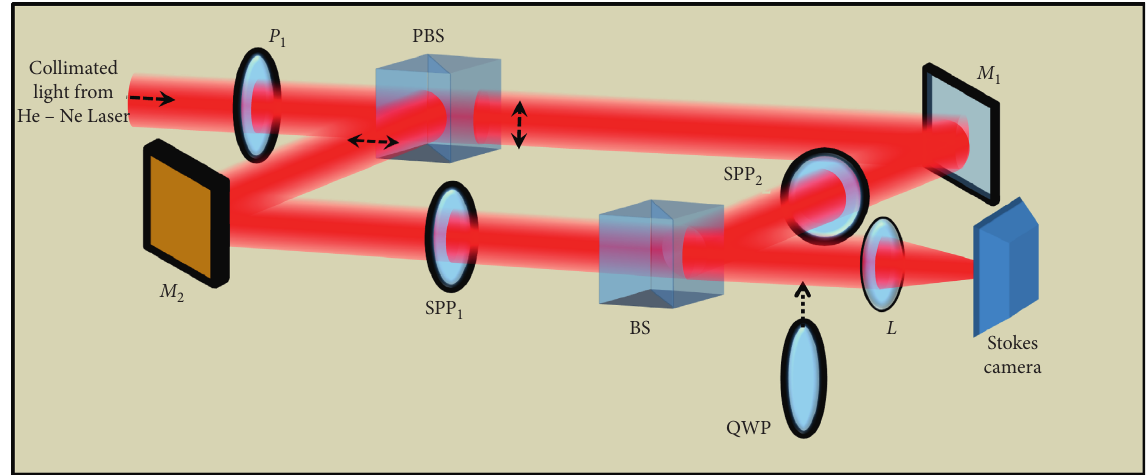
Figure 10: Experimental generation of Stokes phases and polarization singularities using scalar vortices. P, polarizer; (P)BS, (polarizing) and M , mirrors; SPP, spiral phase plate; QWP, quarter wave plate; L, lens; stokes beam splitter; M 1 2